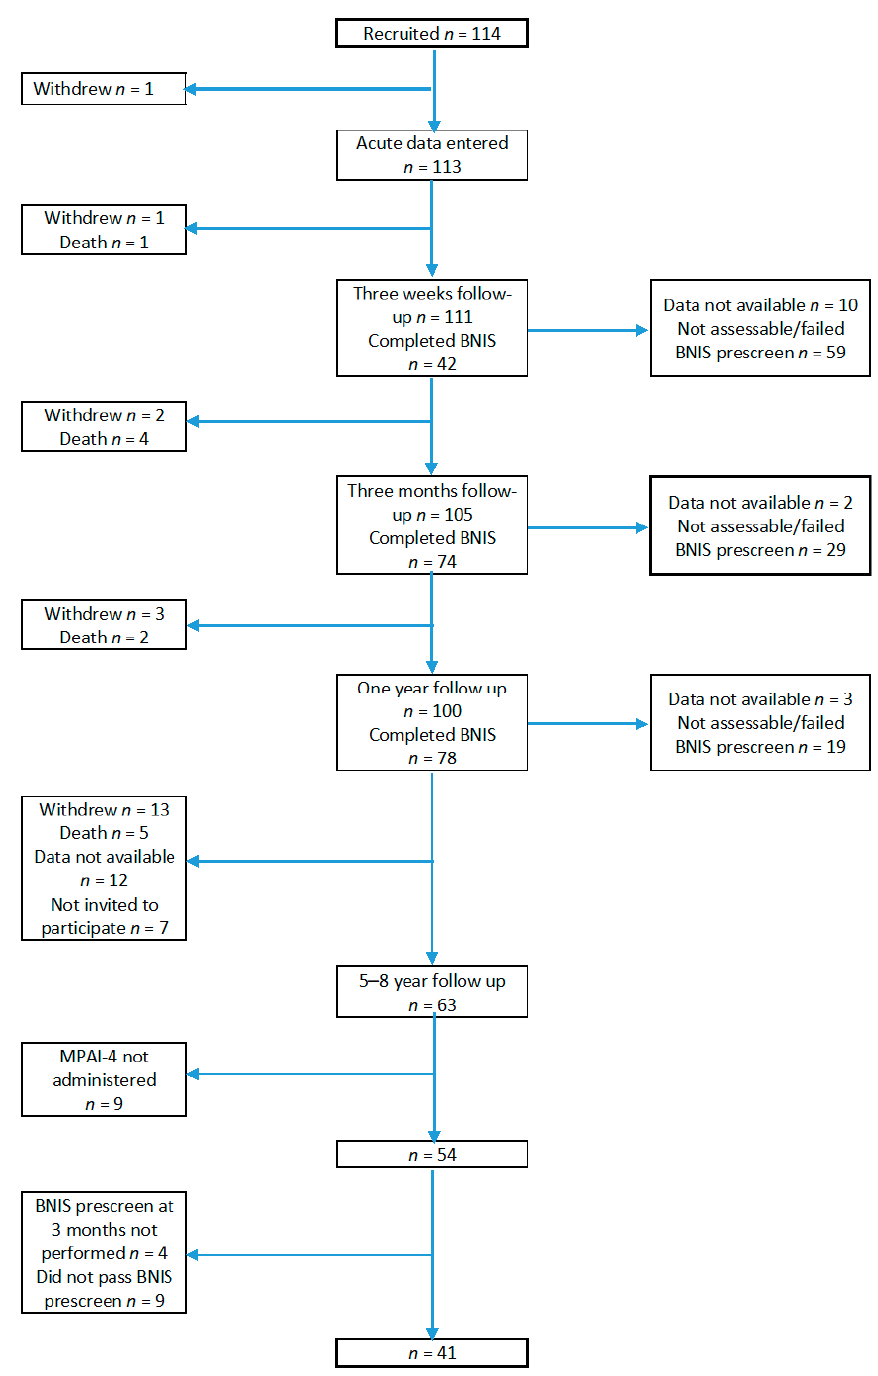
Figure 1. Flowchart of the Probrain long-term follow-up study.